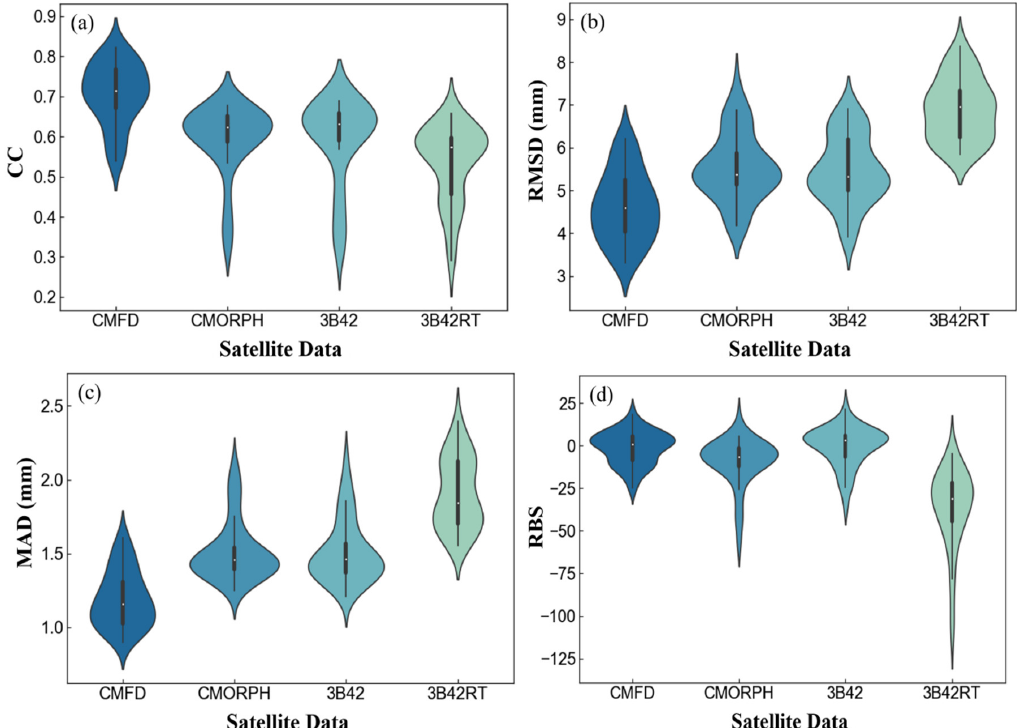
Figure 2. Variation in the statistical metrics of four satellite precipitation products against observed precipitation data over Beijing for ( a ) CC, ( b ) RMSD, ( c )MAD, and ( d ) RBS.